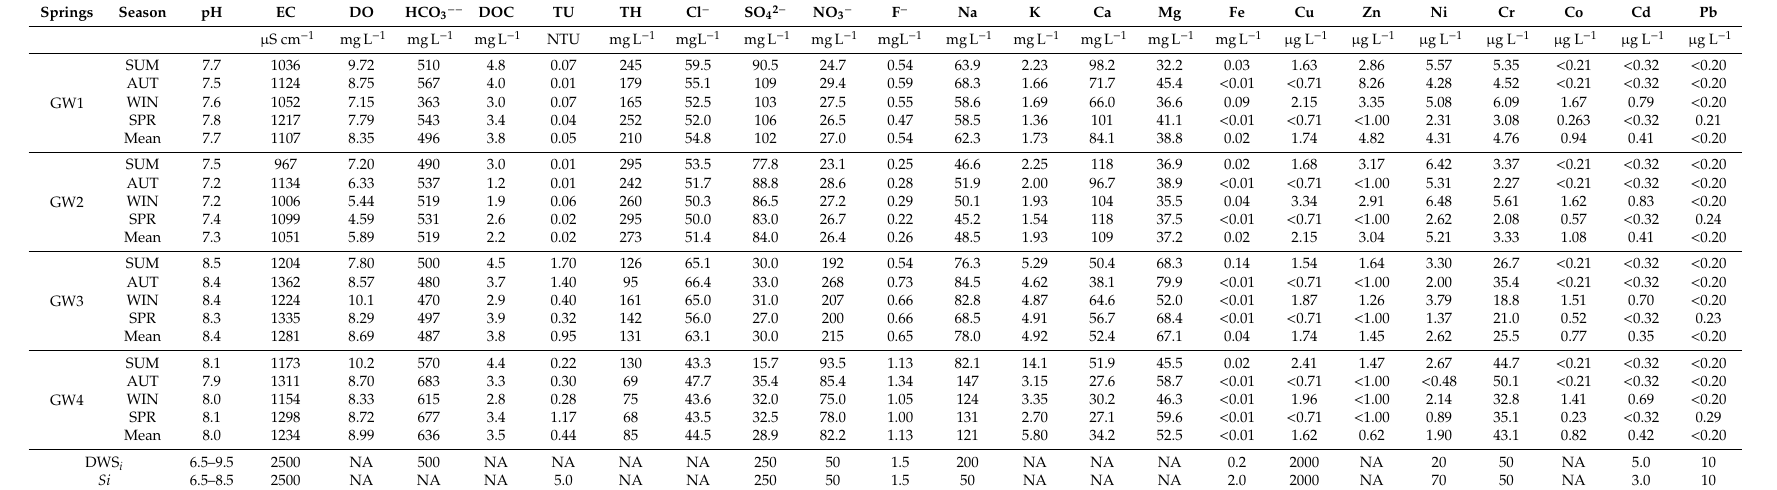
Table 4. Physico-chemical parameters of the four studied karstic springs (SUM = summer, AUT = autumn, WIN = winter, SPR = spring, DWS i = drinking water standards according to the Directive 98 / 83 / EC [28], and S i = guideline values according to WHO [40]) from Dobrogea region, Romania. Springs